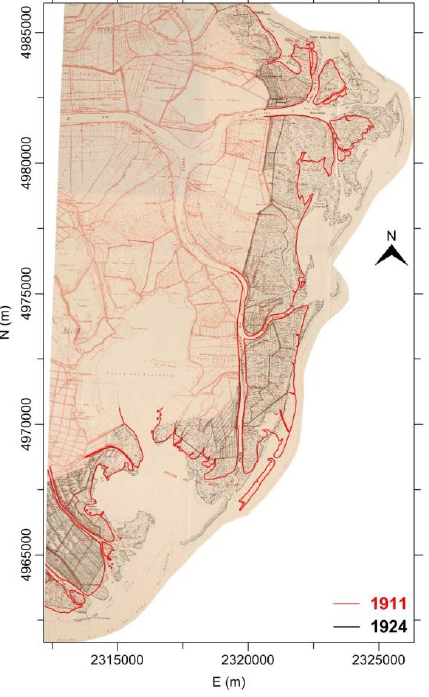
Figure 3. Coverage and alignment of the 1911 (in red )–1924 (in black ) archival cartography (1:25,000 scale) in the Gauss–Boaga Italian reference system. 2-D GCPs were used to generate the photo-plan mosaic of 1933, 1944 (Figure 4, with